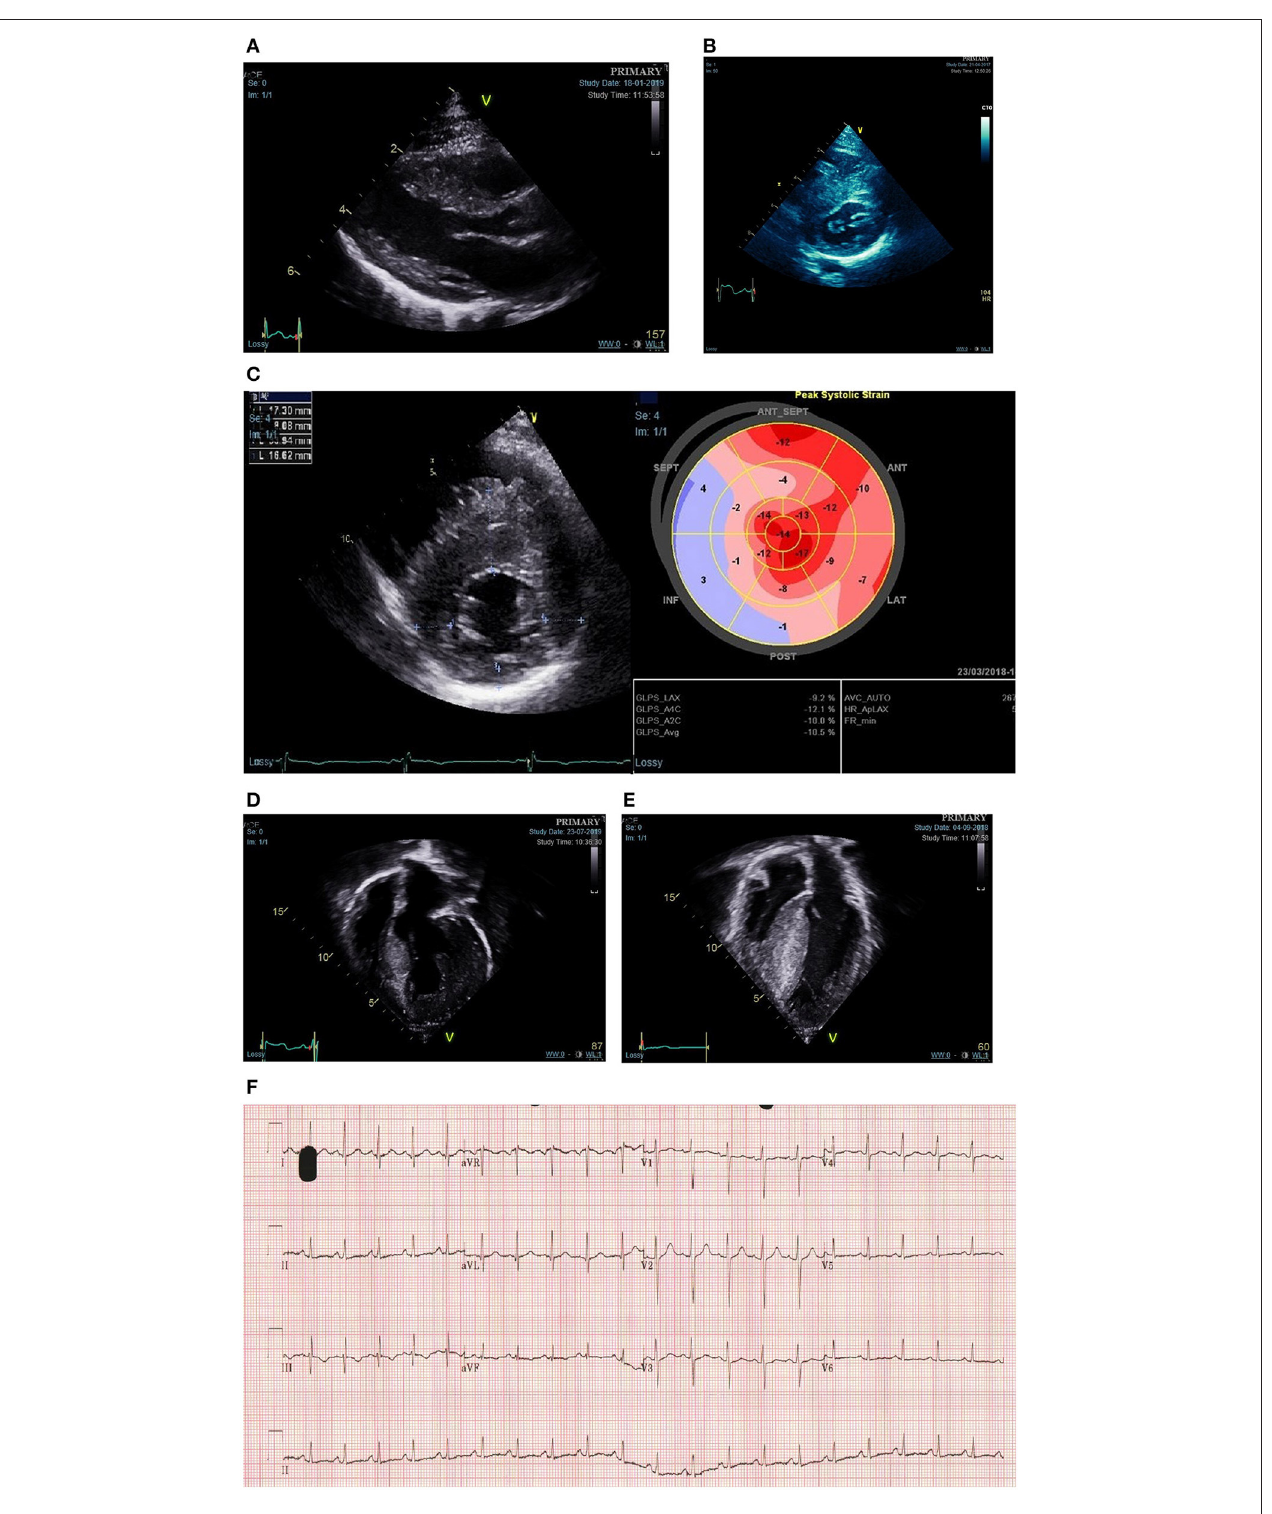
FIGURE 1 | Phenotypic spectrum of sarcomeric hypertrophic cardiomyopathy presenting during childhood. (A) Mild asymmetric LVH secondary to a disease causing MYH7 variant diagnosed in infancy through family screening. (B) Moderate-severe asymmetric LVH secondary to disease causing MYBPC3 variant diagnosed in infancy following referral with murmur. (C) Reduced longitudinal strain in a teenager with asymmetric LVH and familial disease. (D) Severe eccentric hypertrophy in a 10-year old with a disease causing alpha-tropomyosin variant. (E) Biventricular hypertrophy in a teenager with compound MYBPC3 variants. (F) ECG showing abnormal repolarisation (flat or negative T waves infero-laterally) in a child heterozygous for familial MYH7 variant with no LVH on echocardiogram.